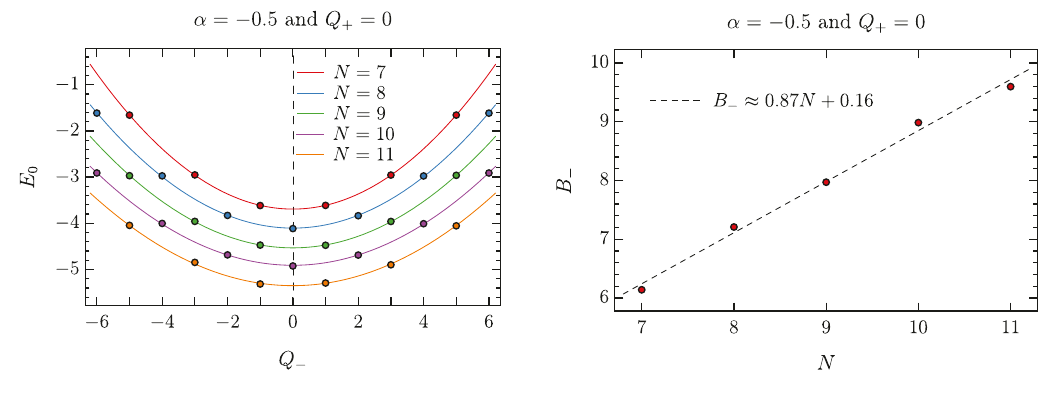
Figure 9 . The E ( Q ) curve(left) at α = − 1 / 2 for the first few Q − sectors at Q + = 0 . For each E ( Q ) curve, we make a quadratic fit E 0 = Q N . The slope of the plot for α = − 1 / 2 is K ED of K DS ≈ 0 . 80 . −